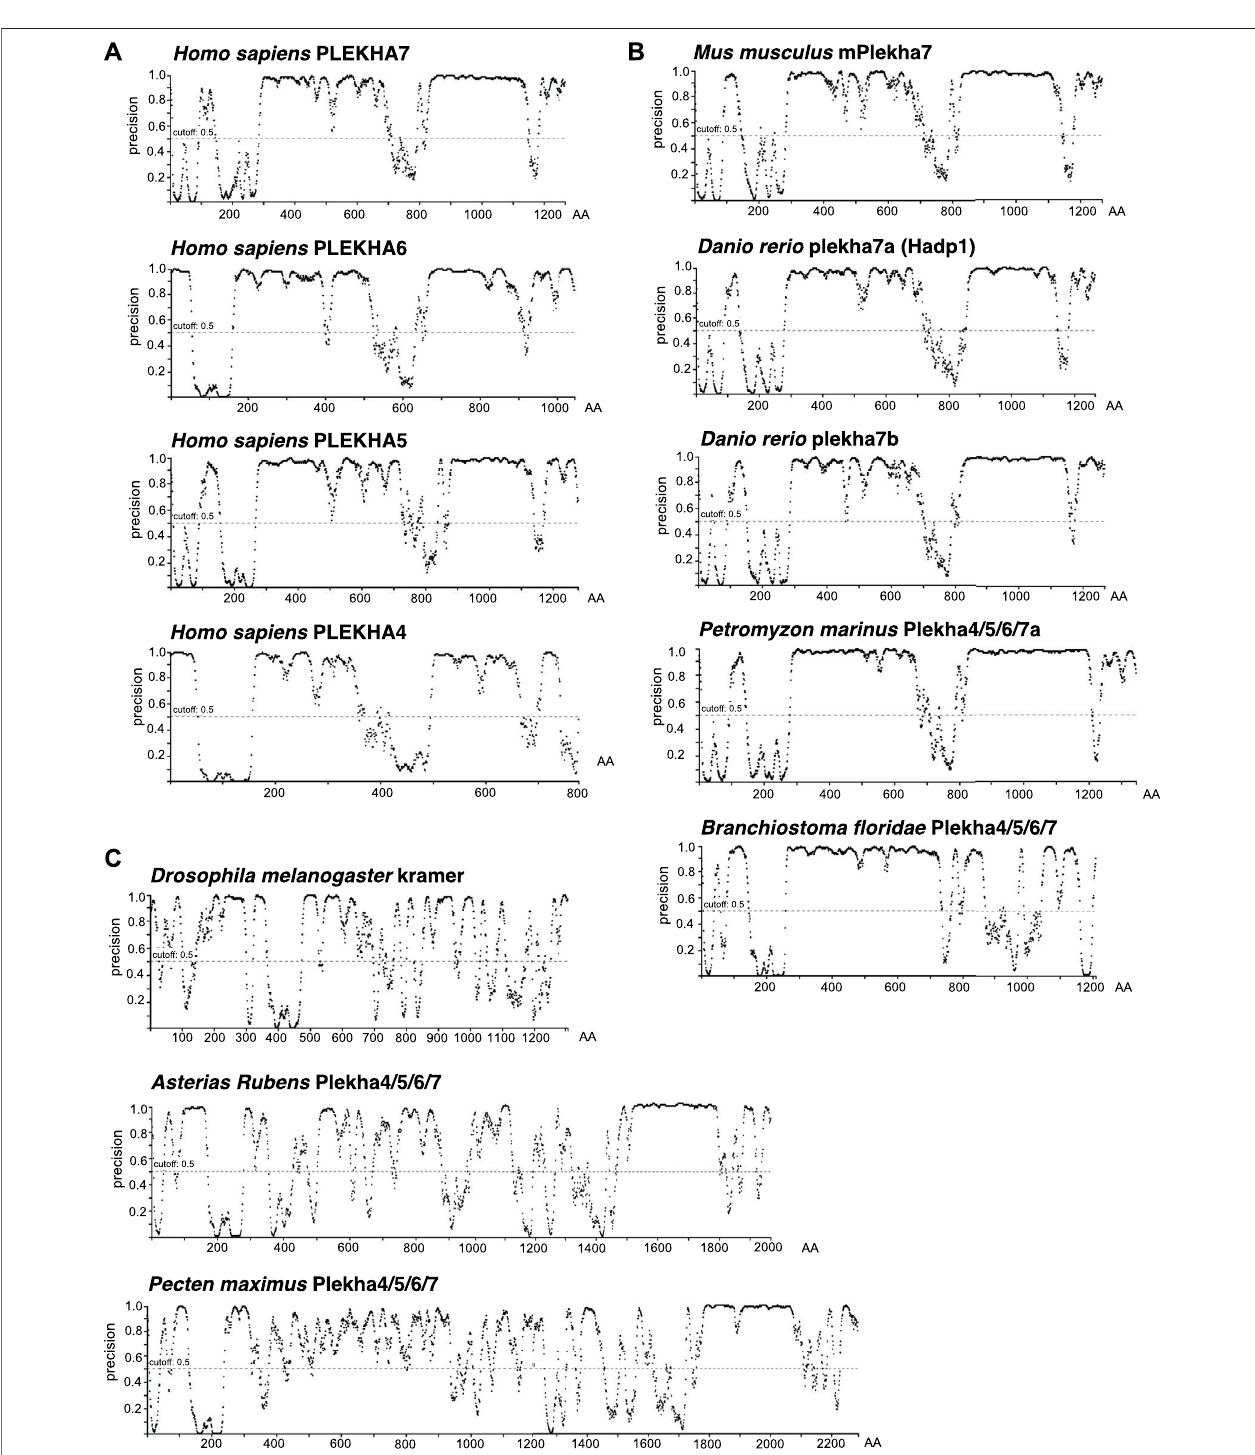
FIGURE 6 | The chordate Plekha4/5/6/7 proteins possess structurally conserved intrinsically disordered regions (IDRs). Intrinsically disorder domain prediction analysisof (A) thehuman( Homosapiens )PLEKHA4/5/6/7 proteins; (B) themouse ( Musmusculus )mPlekha7, zebra fi sh ( Danio rerio ) plekha7a and b,lamprey Plekha4/ 5/6/7a ( Petromyzon marinus XP_032815647) and the lancelet Plekha4/5/6/7 ( Branchiostoma fl oridae XP_035672282.1) proteins; and (C) the invertebrate Pecten maximus (XP_033751660.1) and Asterias rubens Plekha4/5/6/7 (XP_033645898.1) proteins retrieved in the BLAST searches ( Figures 1B , 2A ), as well as the Drosophilamelanogaster kramer.AnalysiswasperformedusingtheDISOPRED3functionofPSIPRED.Schematicsrepresentingtheprobabilityofaproteinregionbeing intrinsically disordered ( “ precision ” on the Y axis). Numbers on the x axis denote amino acid positions (AA) of each protein.